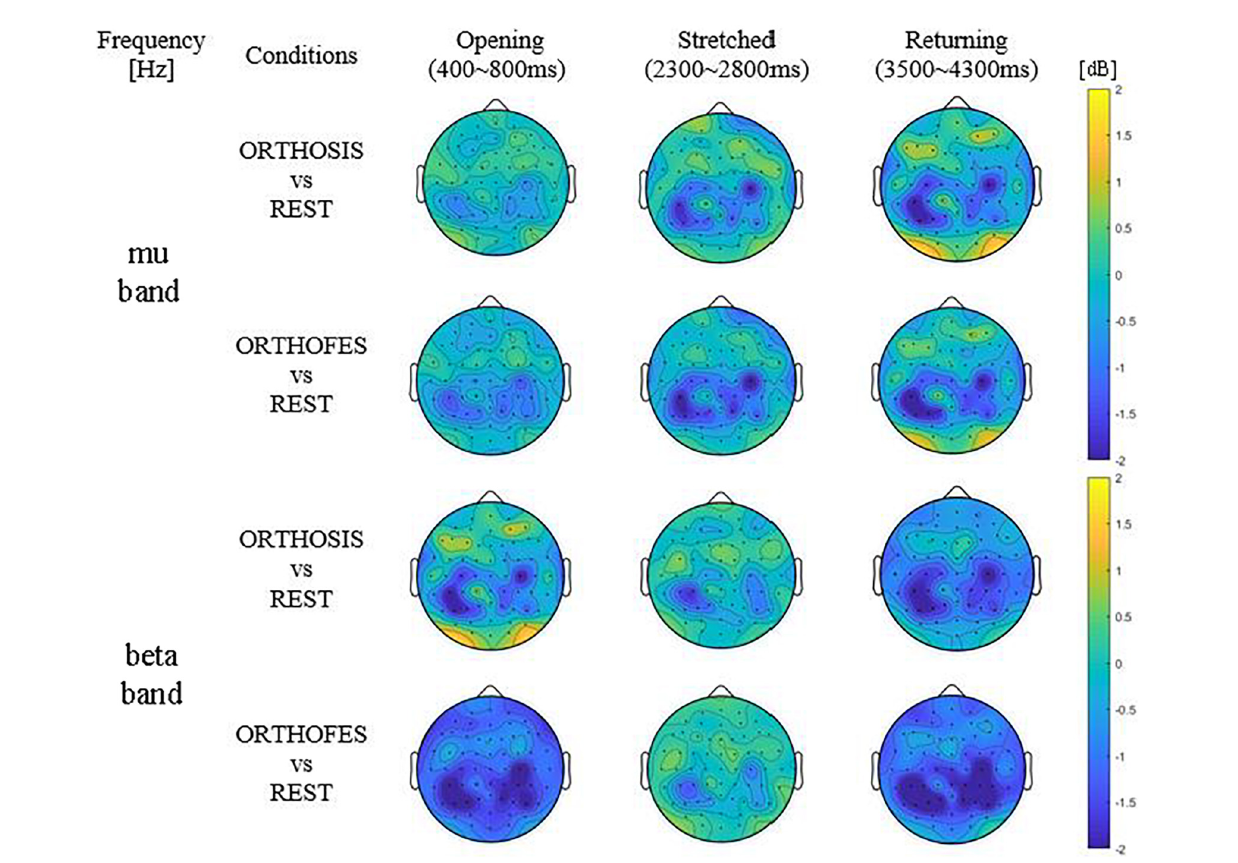
FIGURE3 Averaged differential power values of all included participants’ data. Topography presenting the power changes in ORTHOSIS and ORTHOFES averaged ( N = 8). The frequency band of each subject was selected from the above information ( Table 1 ). The power changes in ORTHOSIS and ORTHOFES were compared to REST. The pronounced power reduction was observed in contralateral S1 and ipsilateral M1 and S1—the color bars fixed scale (–2 to 2 dB) for comparisons between conditions and phases. (S1 = primary somatosensory cortex, M1 = primary motor cortex). Yellow indicates ERS (power increase in dB), and blue shows ERD (power decrease in dB) compared with REST, as expressed in the color bar.